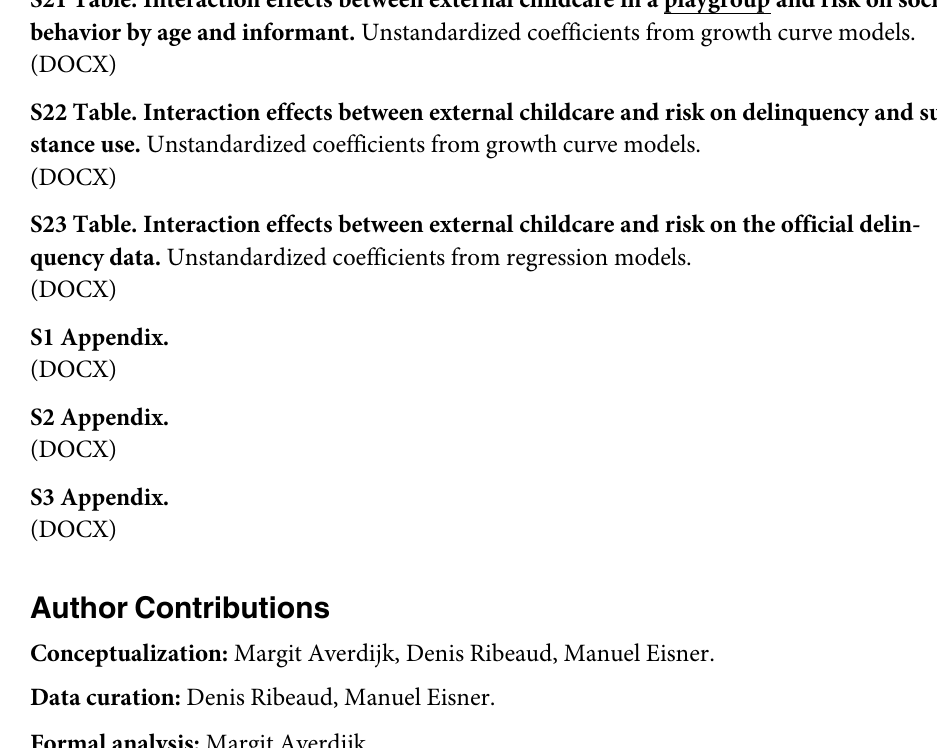
S15 Table. Relations between external delinquency and official measures of delinquency. Unstandardized coefficients from regression models. S16 Table. Interaction effects between external childcare and risk on social behavior. Unstandardized coefficients from growth curve models. S17 Table. Interaction effects between external childcare by family members and risk on social behavior by age and informant. Unstandardized coefficients from growth curve mod- els. S18 Table. Interaction effects between external childcare by acquaintances and risk on social behavior by age and informant. Unstandardized coefficients from growth curve mod- els. S19 Table. Interaction effects between external childcare by daycare mothers and risk on social behavior by age and informant. Unstandardized coefficients from growth curve mod- els. S20 Table. Interaction effects between external childcare in a daycare center and risk on social behavior by age and informant. Unstandardized coefficients from growth curve mod- els. S21 Table. Interaction effects between external childcare in a playgroup and risk on social behavior by age and informant. Unstandardized coefficients from growth curve models. S22 Table. Interaction effects between external childcare and risk on delinquency and sub- stance use. Unstandardized coefficients from growth curve models. S23 Table. Interaction effects between external childcare and risk on the official delin- quency data. Unstandardized coefficients from regression